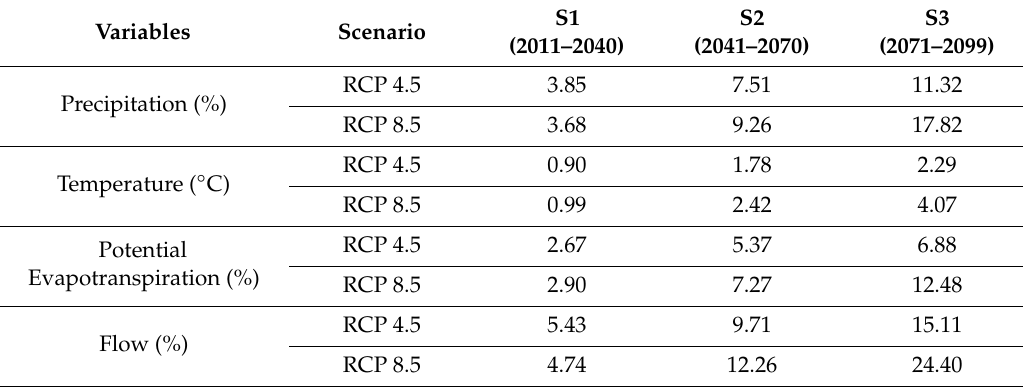
Table 8. Relative change (%, ◦ C) of the 30-year average annual precipitation, temperature, potential evapotranspiration, and flow during three future periods for RCP scenarios 4.5 and 8.5 in South Korea. The values were calculated first by converting daily data into annual data. The relative change